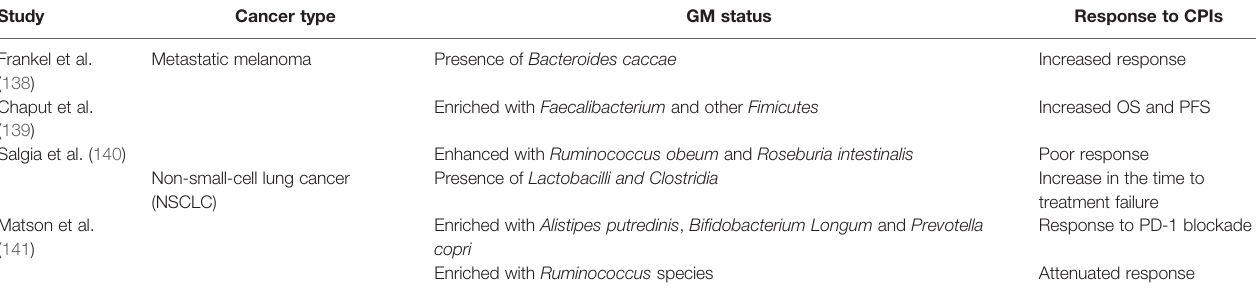
TABLE 1 | Studies evaluating the relationship between GM and